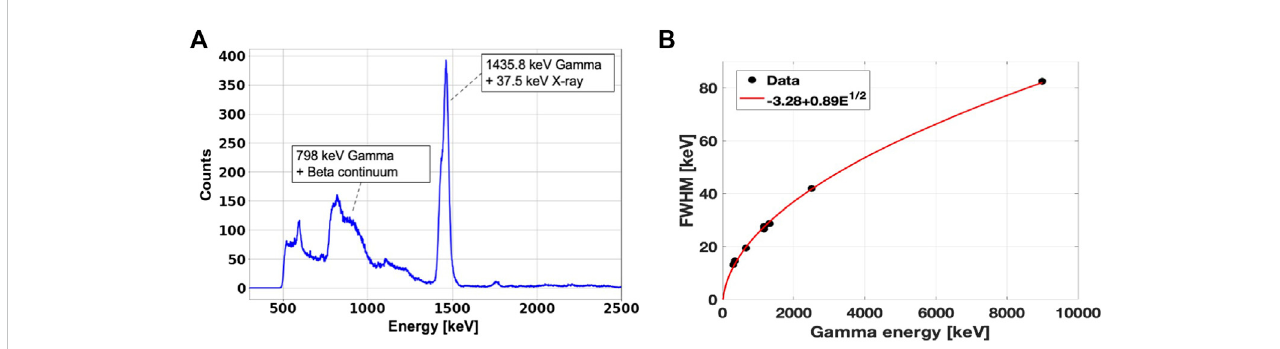
FIGURE 1 (A) : Measured energy spectrum of the LaBr 3 :Ce internal radioactivity. (B) : LaBr 3 :Ce energy resolution measured with radioactive sources of 60 Co, 133 Ba, 137 Ba and AmBeNi. The values on the y -axis represent the peaks FWHM. The experimental points are fi tted with the function FWHM (cid:1) a + b